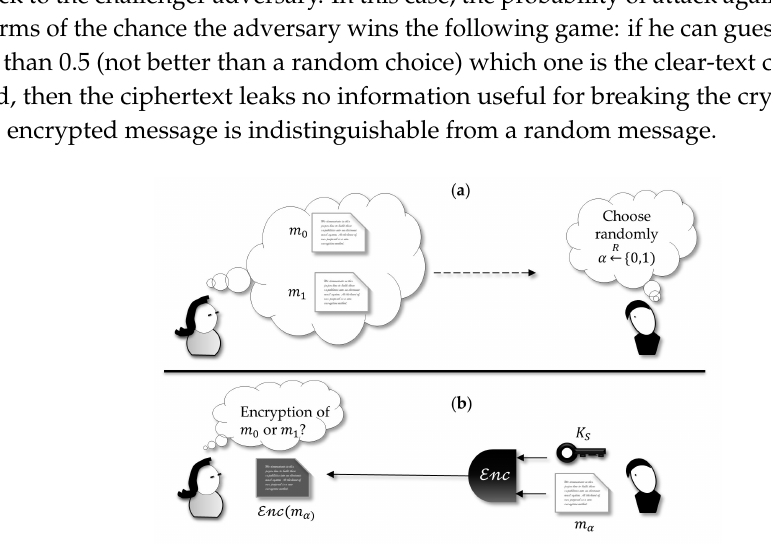
Figure 2. ( a ) The challenger Alice takes two messages randomly chosen and sends them to the signer Bob. ( b ) The signer flips a coin and chooses either 0 or 1, then he encrypts one of the messages and sends the enciphered message back to the challenger, who wins the game if she finds which m was